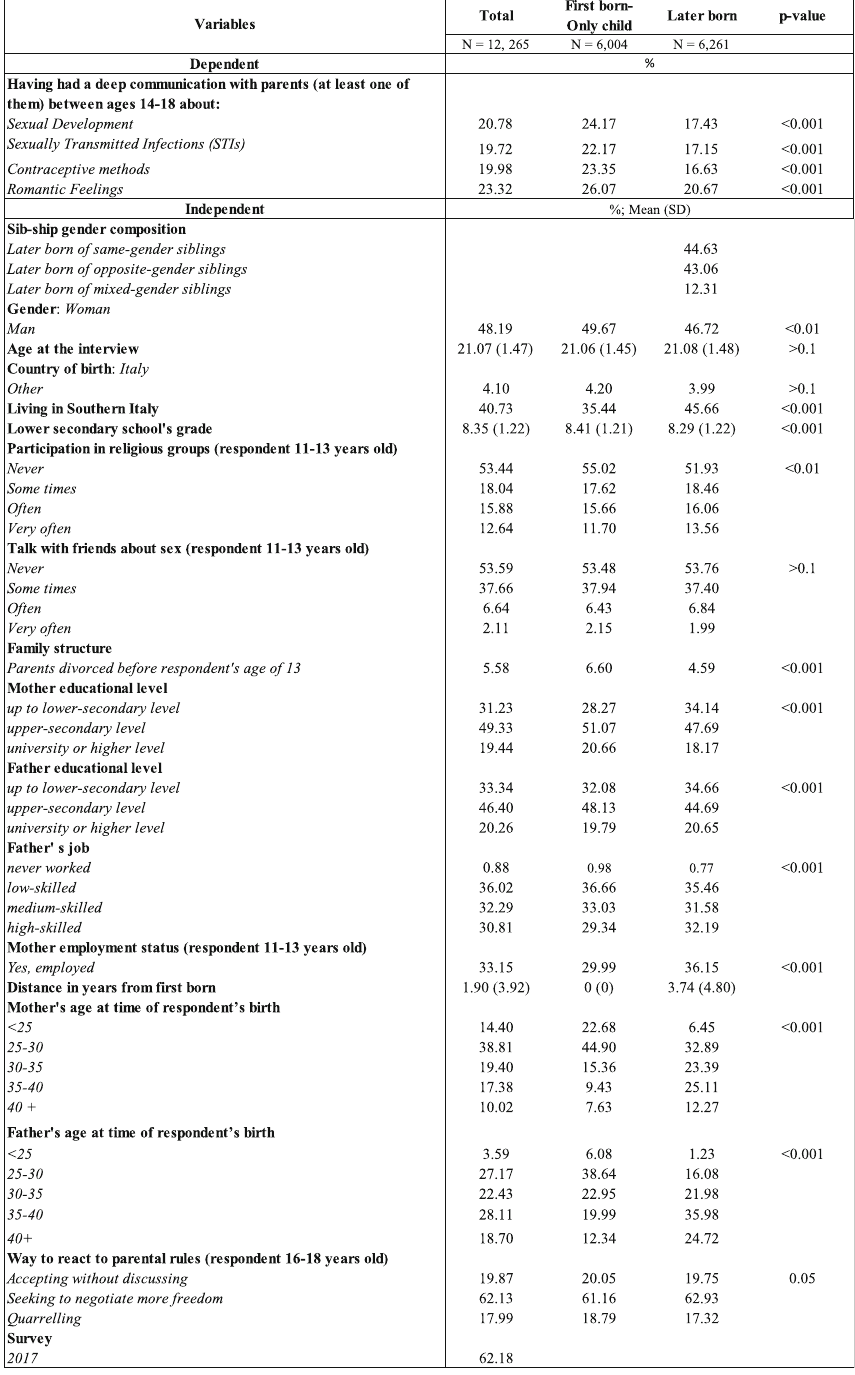
Table 1 Distribution of the sample variables by birth